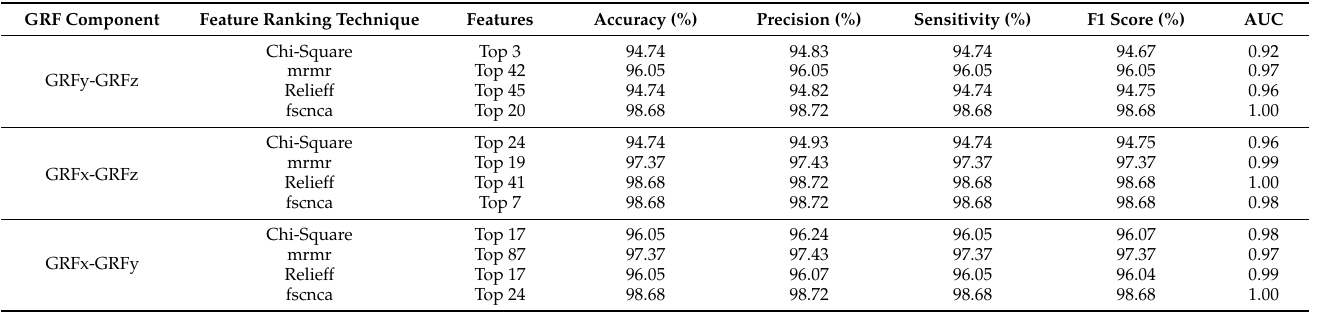
Table 8. Evaluation matrix for two-channel analysis for GRF data using different feature selection techniques.